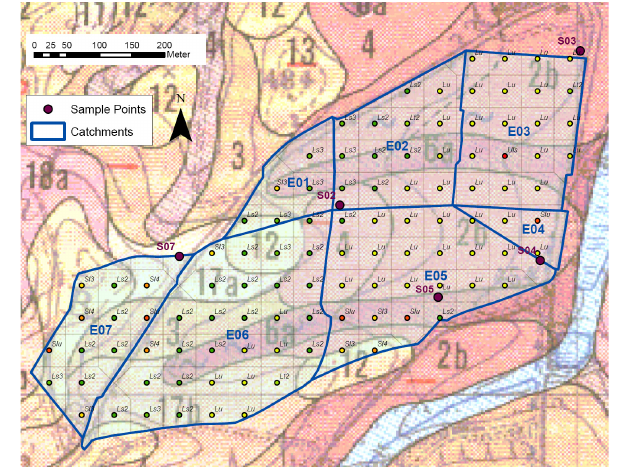
Figure 7: Location of Hood Infiltrometer Sampling Points and Soil Classification of Topsoil 2 Fig. 7. Location of Hood Infiltrometer Sampling Points and Soil (S CHEINOST et al 1997) in Different Catchments, Scheyern (Backgound: Bavarian Soil Map 3 Classification of Topsoil (Scheinost et al., 1997) in Different Catch- ments, Scheyern (Backgound: Bavarian Soil Map 1:25000). Soil Type according to Grain Size Distribution (German Soil Classification) 5 Sample